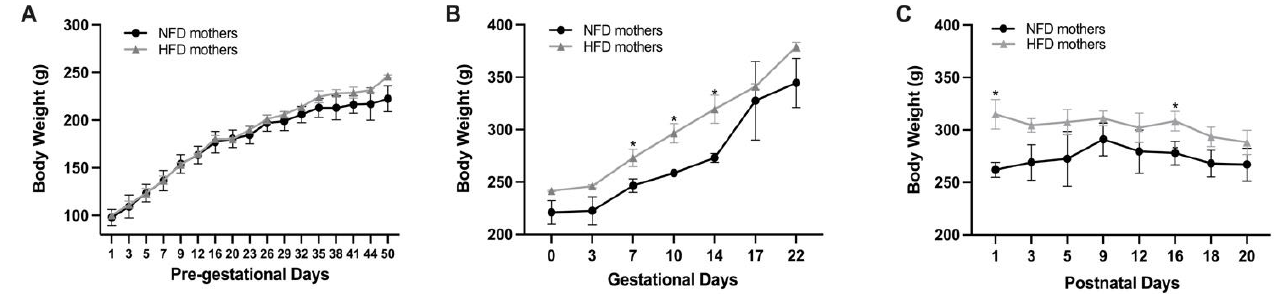
Figure 2. Maternal body weight before gestation ( A ), during gestation ( B ), and during lactation ( C ). Bars show mean ± SD, n = 7 per group. Significant difference between groups was indicated by *, p < 0.05. The body weight and adiposity of rat pups are shown in Figure 3. At P2, a significantly higher body weight was noted in pups in the NFD group than the HFD group (9.36 ± 0.32 vs. 8.57 ± 0.45 g, p < 0.05). The HFD group started to show higher adiposity from P11,